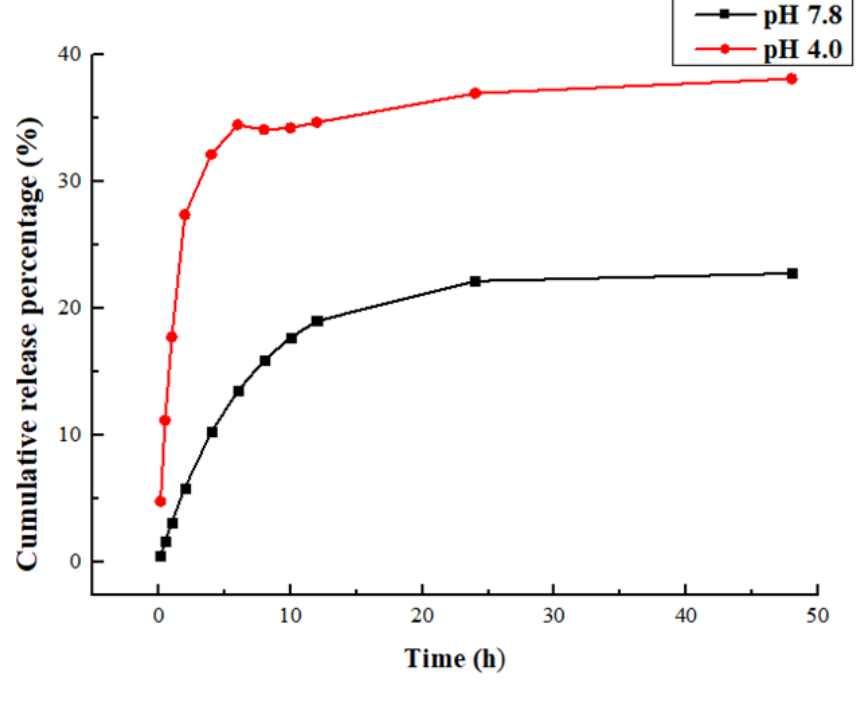
Figure 3. Cumulative release curve.